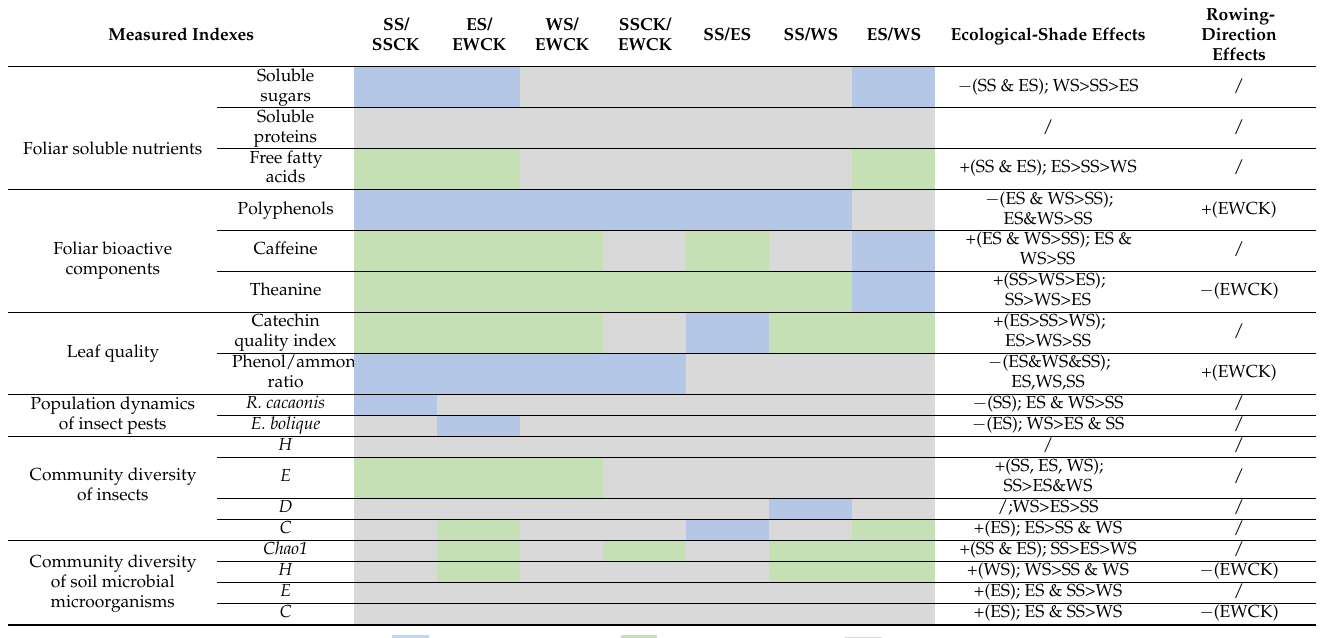
Table A2. Summary of the effects of ecological shading by roadside trees and row direction on the contents of soluble nutrients and bioactive components, and the quality indexes of tea, occurrence of two key pests, and community indexes of insects and soil microbes in the tea plantation.